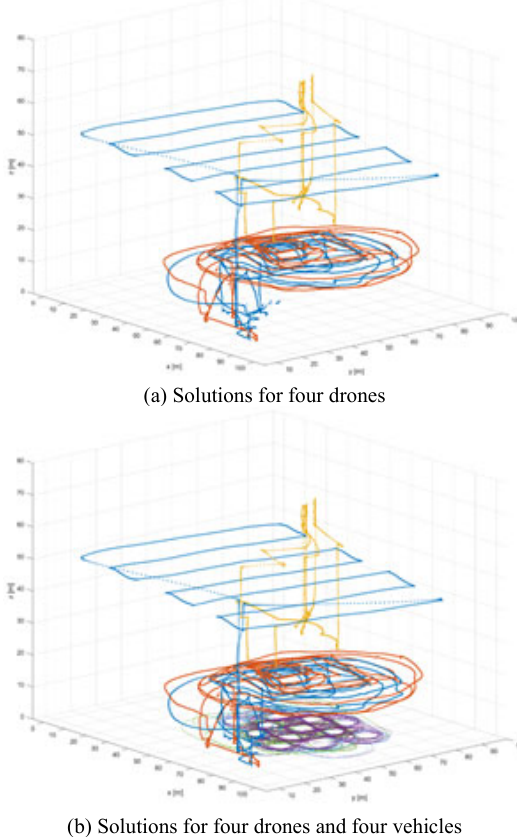
Figure 8 . Collaborative network-based